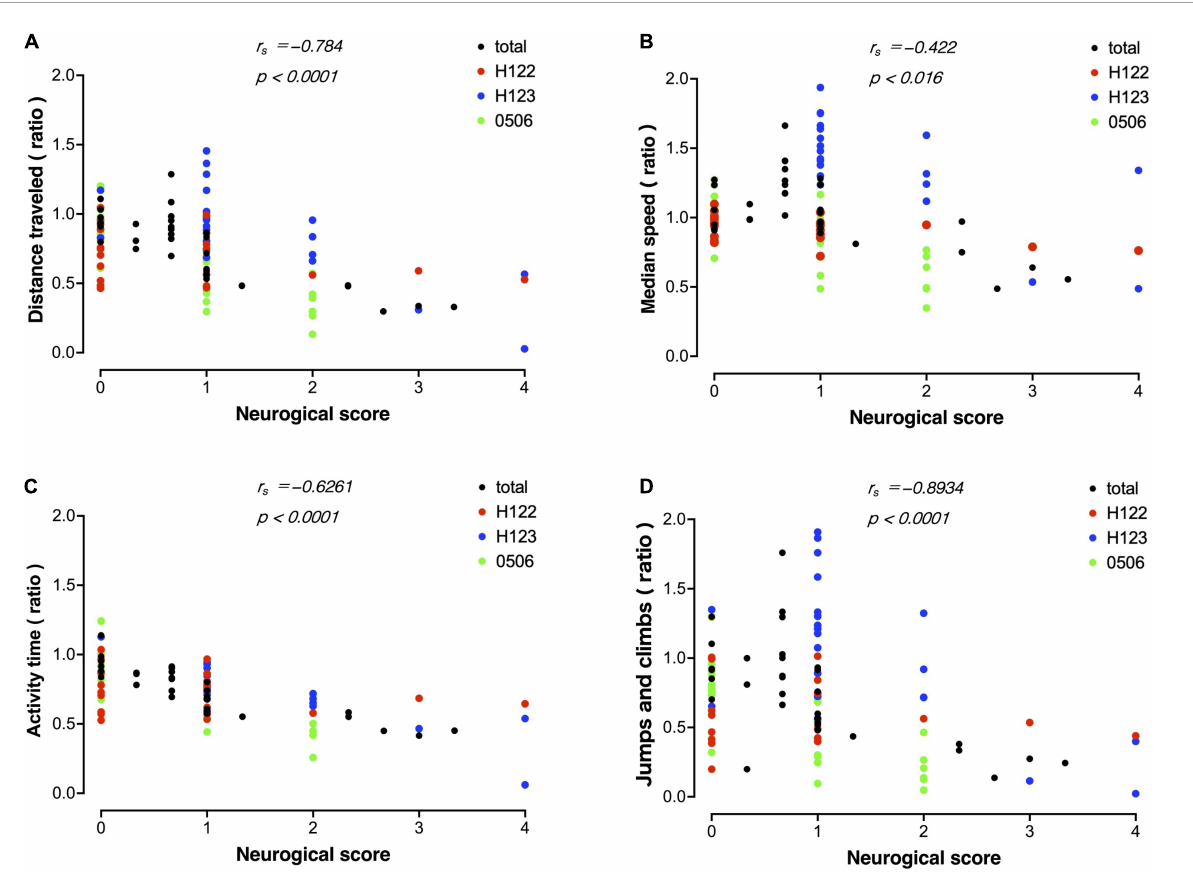
FIGURE7 Correlation between evaluation by MarmoDetector and conventional neurological scores Scatter plot discriminates among data from individual animals besides total. (A) Scatter plot of distance traveled and neurological score. X -axis: neurological score, Y -axis: preoperative/postoperative distance traveled. (B) Scatter plot of median speed and neurological score. X -axis: neurological score, Y - axis: preoperative/postoperative median speed. (C) Scatter plot of activity time and neurological score. X -axis: neurological score, Y - axis: preoperative/postoperative activity time. (D) Scatter plot of jumps/climbs and neurological score. X -axis: neurological score, Y - axis: preoperative/postoperative activity time. Both indices were significantly correlated with the neurological score. Correlation analysis was performed using Spearman’s rank